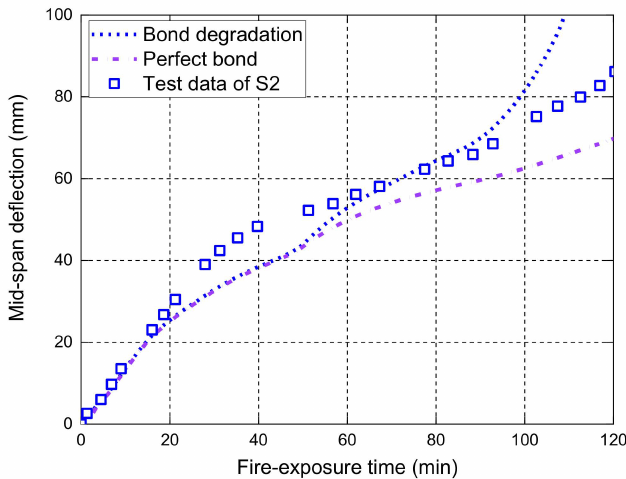
Figure 12. Effect of bond degradation on the midspan deflection responses of S2.